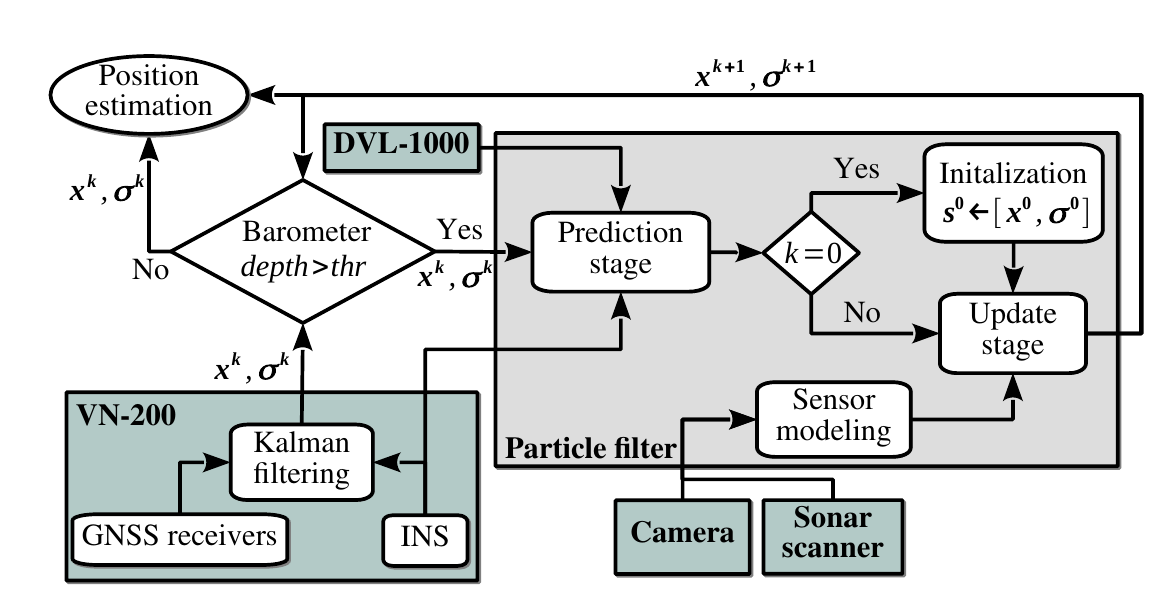
Figure 11. Flowchart of the navigation